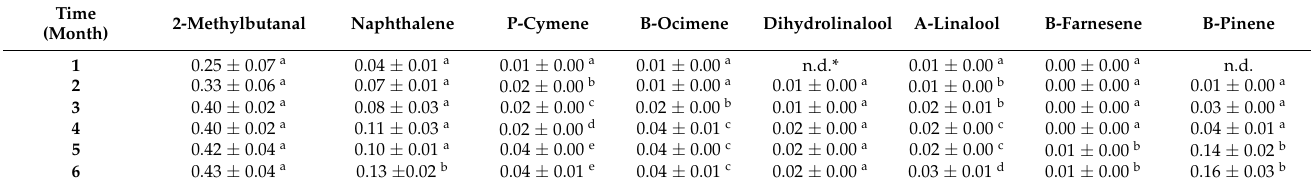
Table 5. Concentration ± SD (mg/Kg) of volatile compounds from basil herb quantified in flavored virgin olive oil (BOO) during the six months of storage.